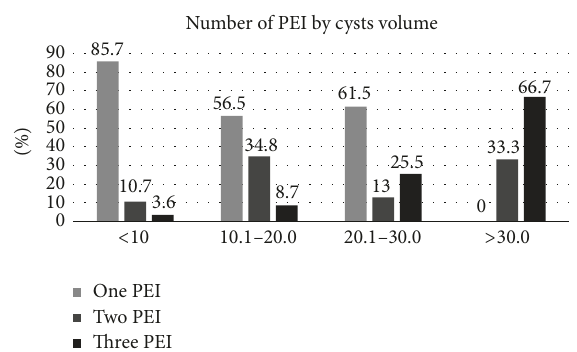
Figure 2: Number of percutaneous ethanol injections (PEI) prac- ticed for thyroid cysts divided by baseline